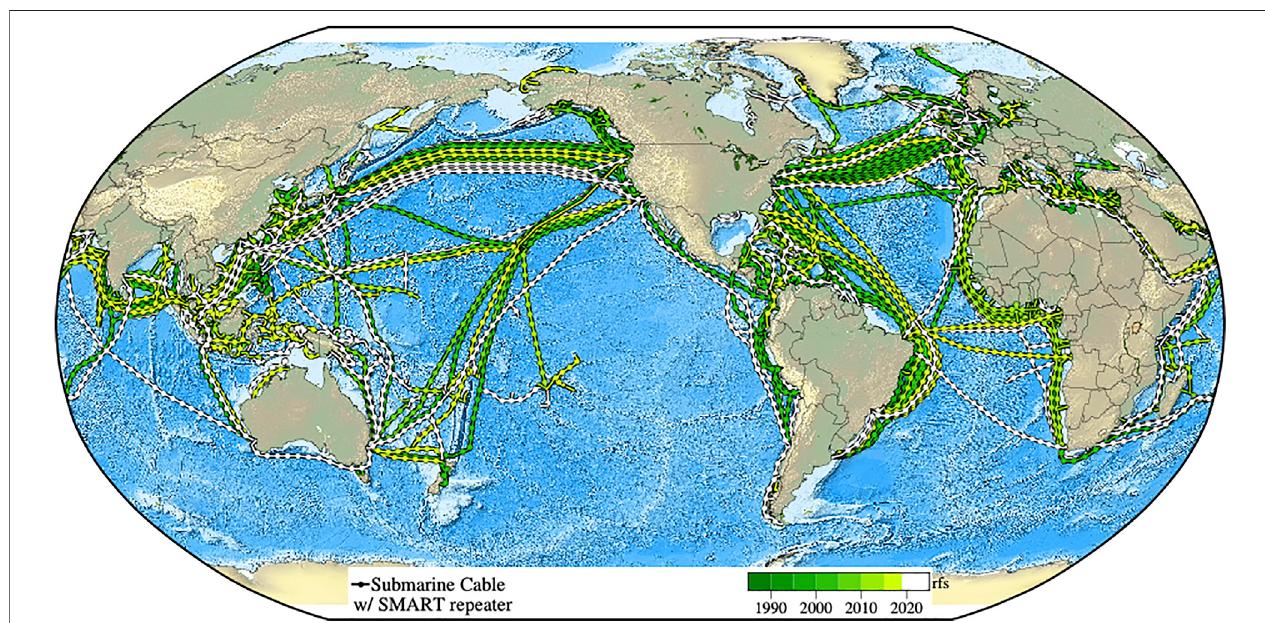
FIGURE1| Currentandplannedcablesspantheoceans,enablingtheInternetandourmodernsociety.Astheyarereplacedandexpandedovertheir10 – 25-years refresh cycle, environmental sensors (pressure, temperature, acceleration) can be added to the cable repeaters every ∼ 100 km, gradually obtaining real time global coverage (for clarity, repeaters are shown only every 300 km; rfs (cid:1) year ready for service). Cable data: TeleGeography ’ s Telecom Resources licensed under Creative Commons ShareAlike. Permission obtained for use of fi gure.